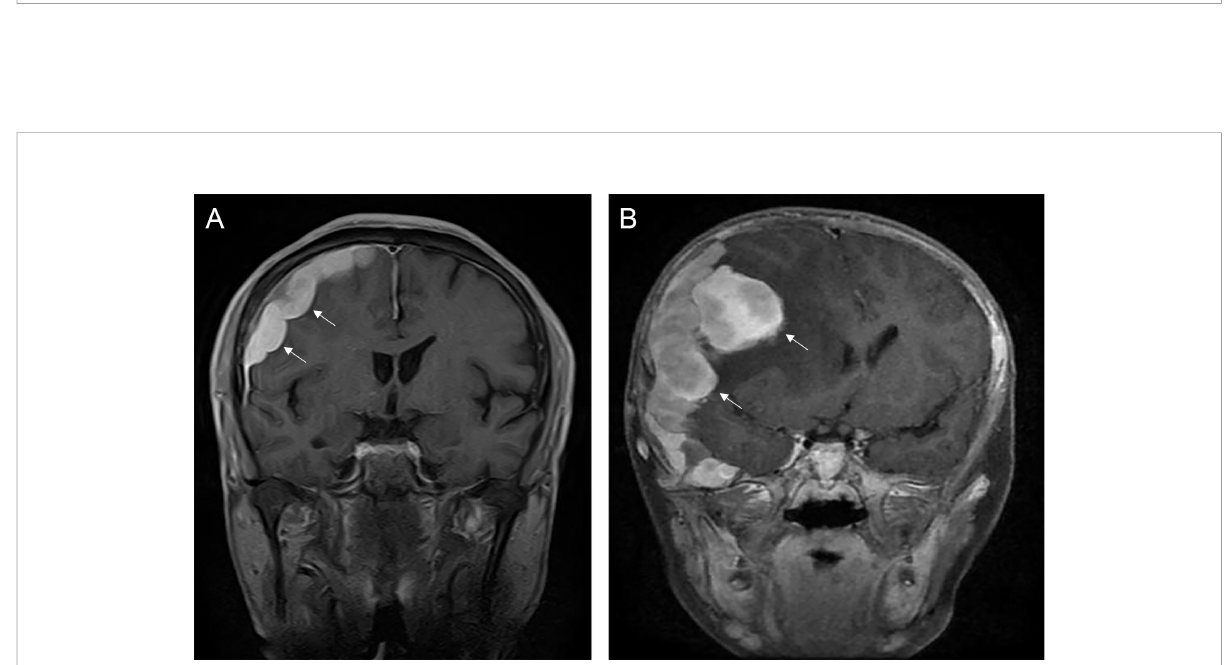
FIGURE 2 The lobulation sign of CNS-RDD. (A, B) MRI images showed the margin of the lesion is lobulated (arrow) on coronal contrast-enhanced